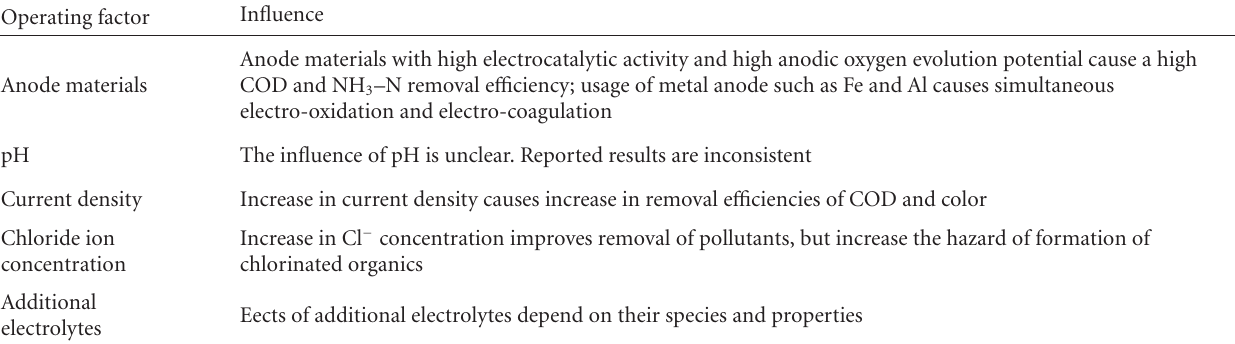
Table 5: Influence of operating factors in electro-oxidation of leachate [57].